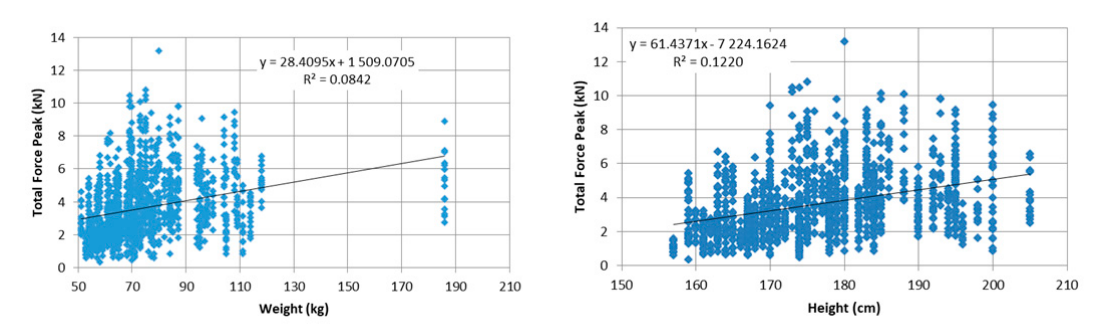
Figure 2. Correlation between peak force and participants weight and height.